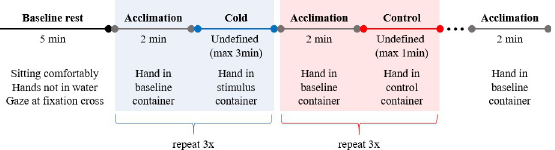
Fig 2. Timing of the experimental paradigm. Note that the order of the cold and control conditions were randomized.